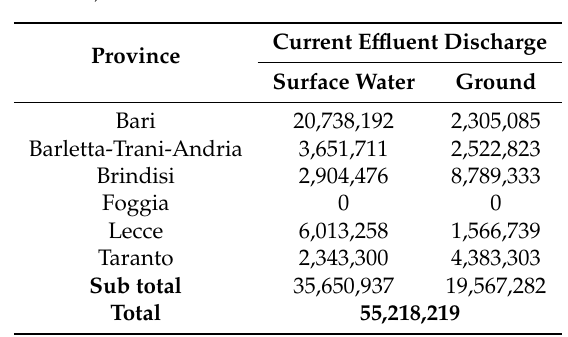
Table 8. Volume (m 3 ) of readily available reclaimed urban wastewater within the groundwater vulnerable zone (Hypothesis